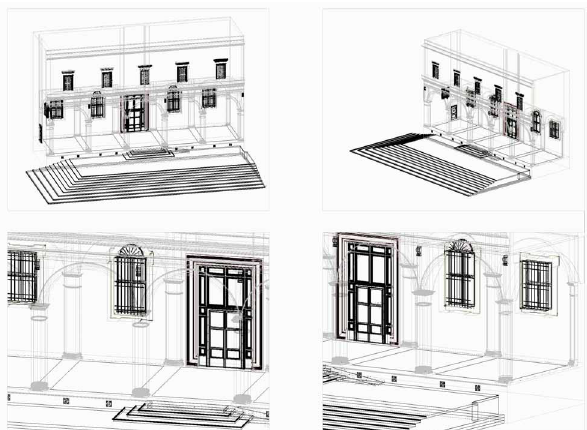
Figure 19. View of the model in wireframe of the entrance